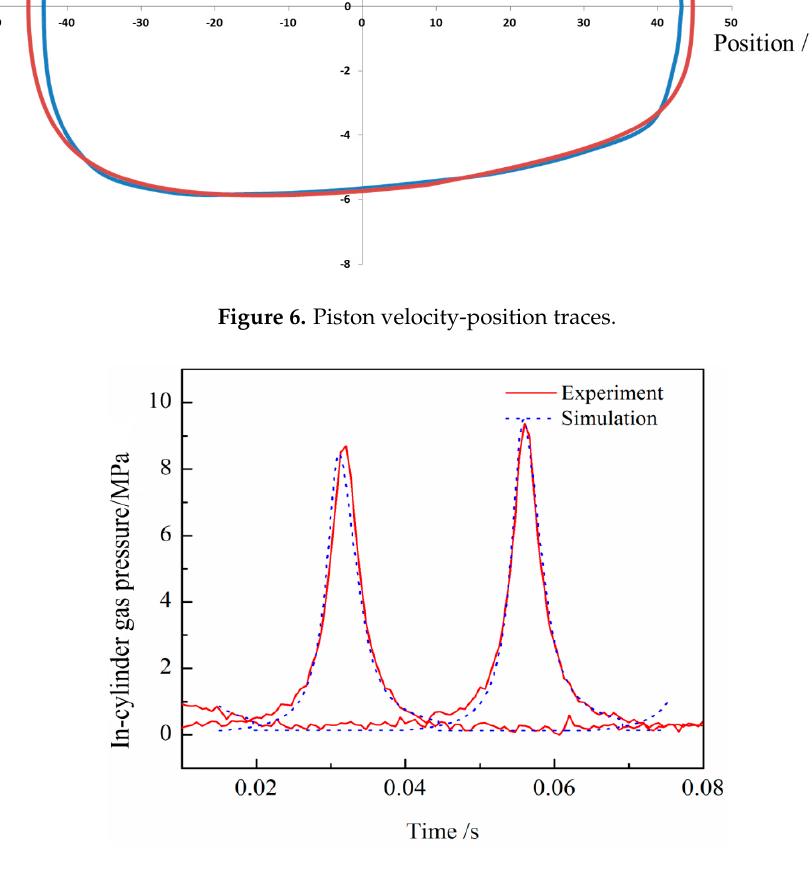
Figure 7. Experimental and simulation results.